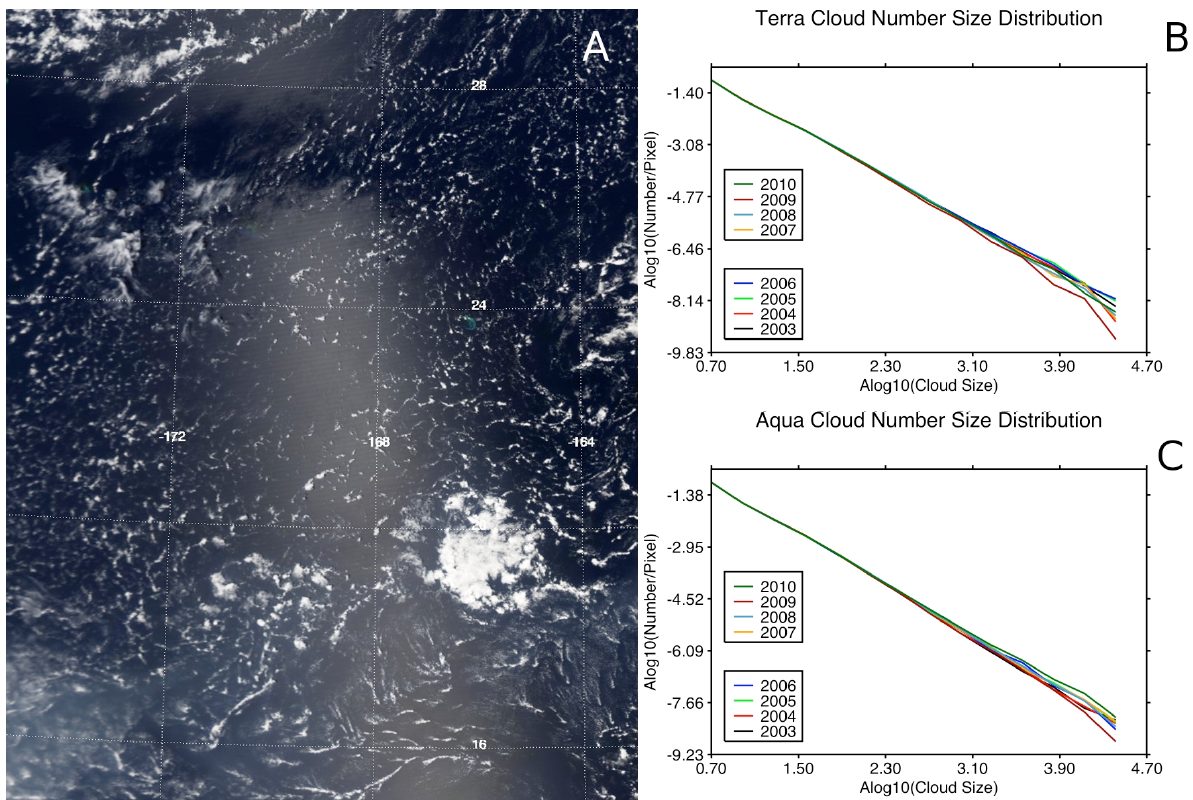
Fig. 1. (A) a MODIS visible image covering roughly the area between 15 ◦ N and 30 ◦ N and between 163 ◦ W and 176 ◦ W. The diversity and complexity of apparent cloud appearance can be appreciated. (B) Cloud size frequency distributions for eight years using Terra data. (C) same as in (B) but using Aqua data. The interannual variation in cloud organization is small. The diurnal variation (Terra versus Aqua) is also small for each